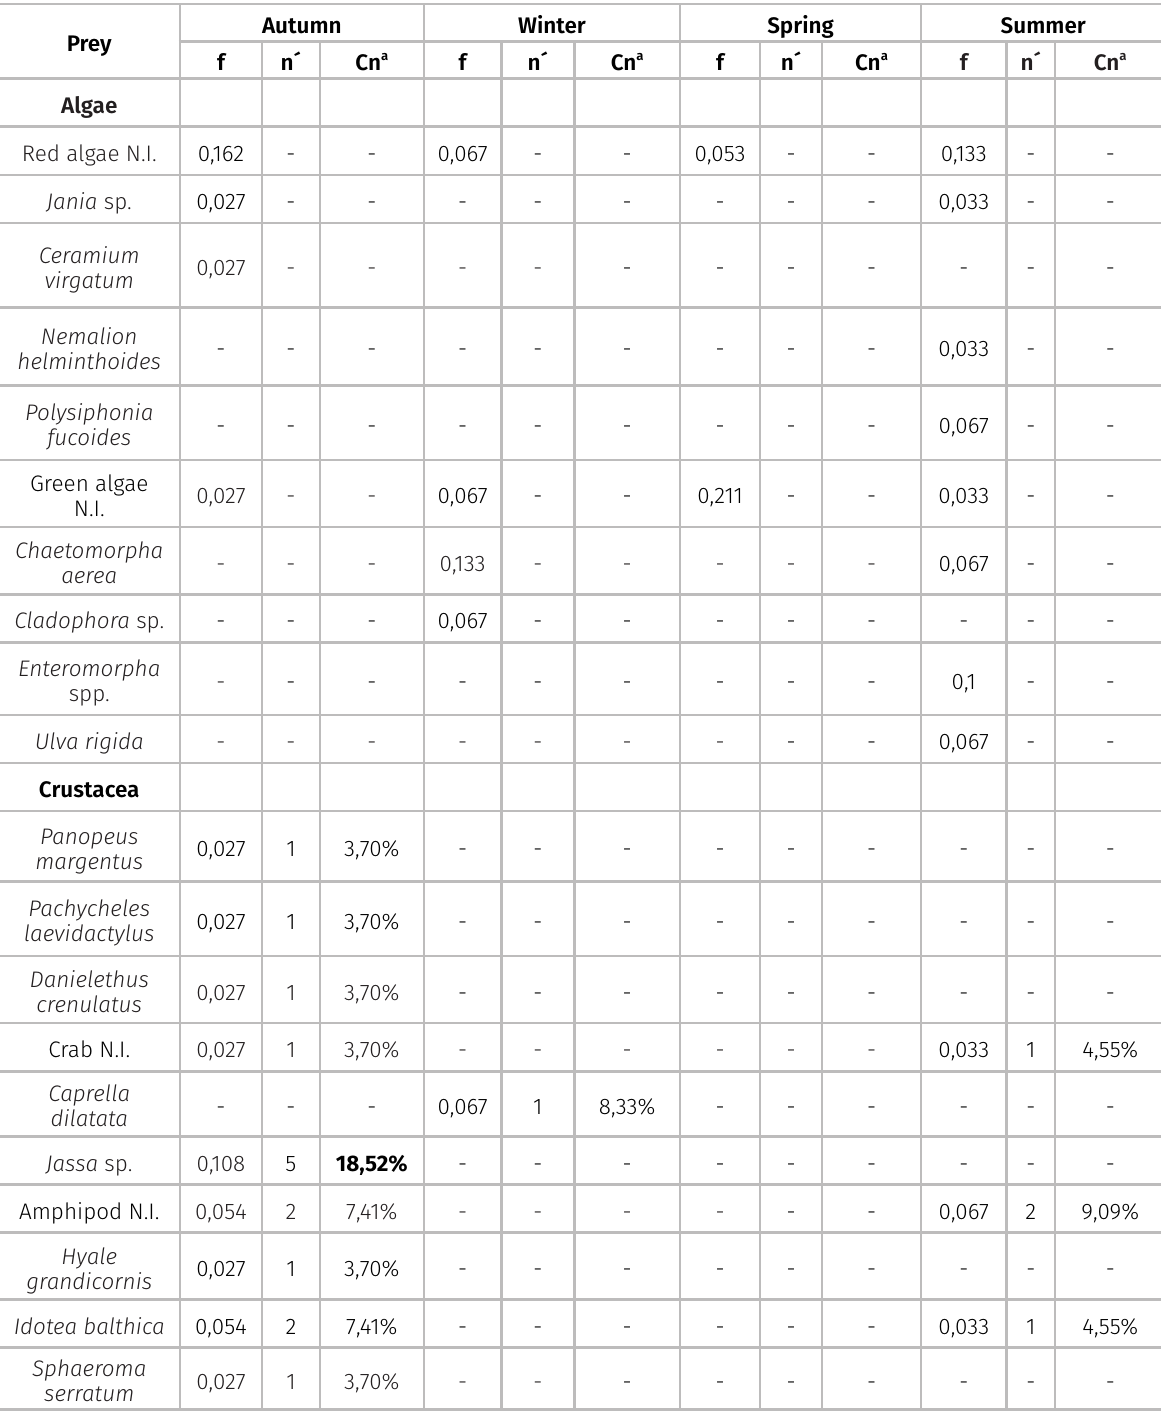
Table II. Prey items consumed by Bunodosoma zamponii in the different seasons during diurnal high tides. Frequency index of prey (f), total number of individuals (n’) and percentage of prey (Cn) of the different items consumed by B. zamponii in the different seasons. N.I. = unidentified. The values in bold correspond to major and minor prey (the others are occasional